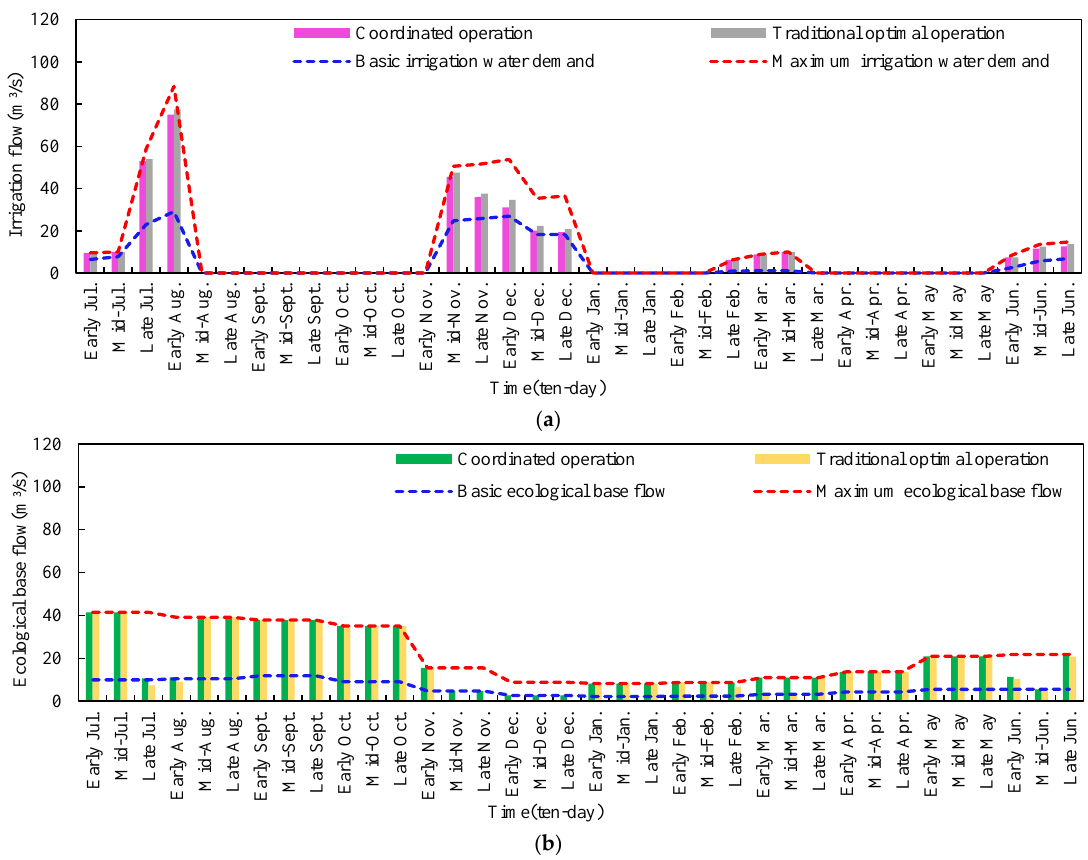
Figure 7. Irrigation and ecological water supply processes of two operation methods in a normal year: ( a ) irrigation; ( b ) ecology.